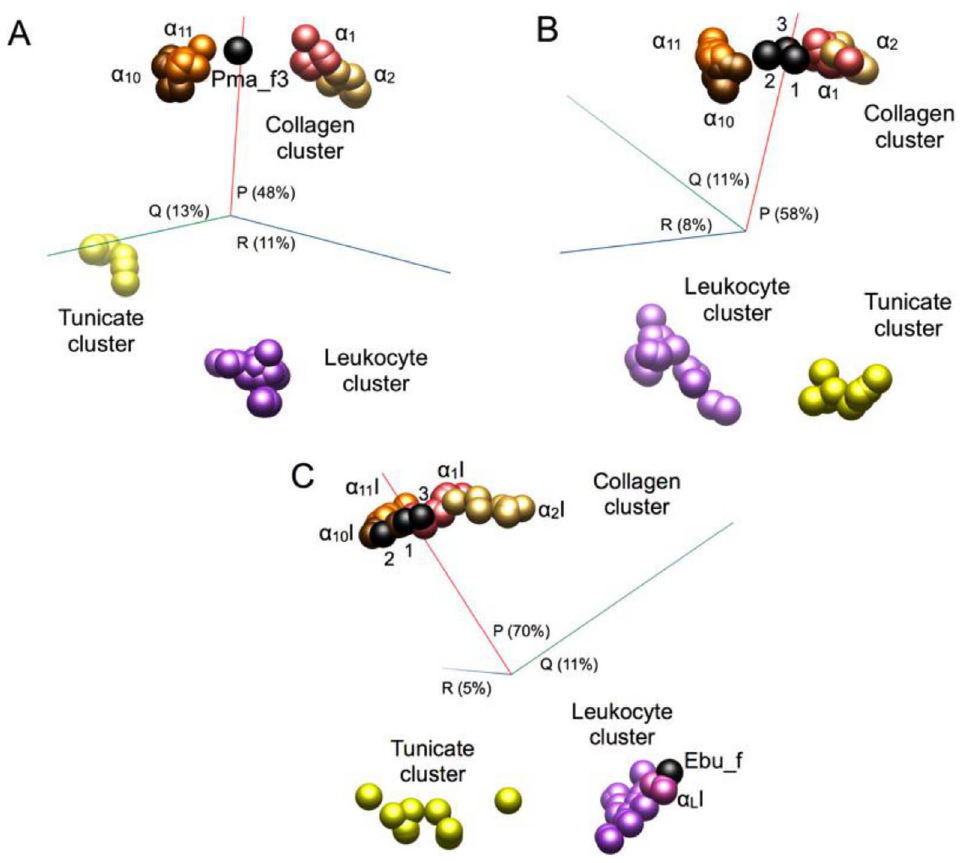
Figure 4. Multivariate plots reflect the details of the phylogenetic analyses. (A) Full-length sequences of the integrin a subunit, (B) sequence regions shared in common with Pma_f1-3, and (C) the a I domain region. The plots were based on distances (JTT scoring) obtained from the sequence alignments. The plots show the relationships among the sequences for the three most informative dimensions and the percentage variance accounted for along the axis is indicated.